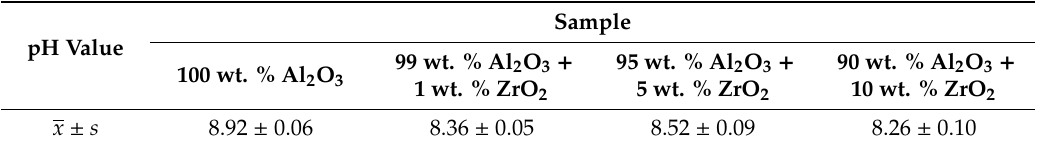
Table 6. Measurement results of pH values on real samples of stable suspensions of monolithic Al 2 O 3 and Al 2 O 3 -ZrO 2 composite ceramics ( 𝑥̅ -mean, s -experimental standard deviation).